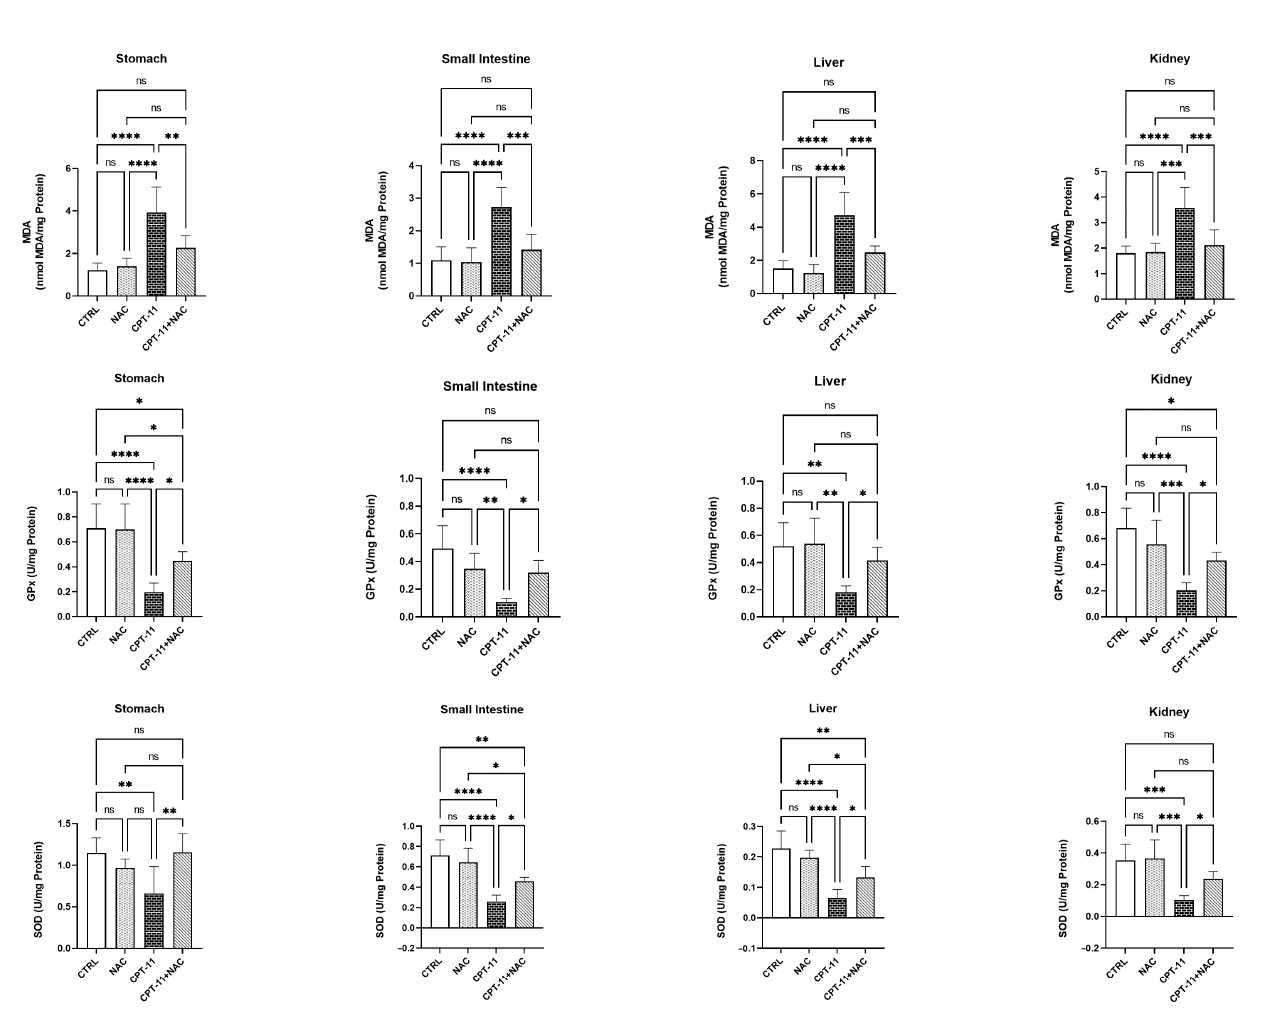
Figure 1. GPx, SOD activities and MDA concentration of stomach, small intestine, liver, and kidney tissue in experimental groups. * p < 0.05, ** p < 0.01, *** p < 0.001 **** p < 0.0001, ns: